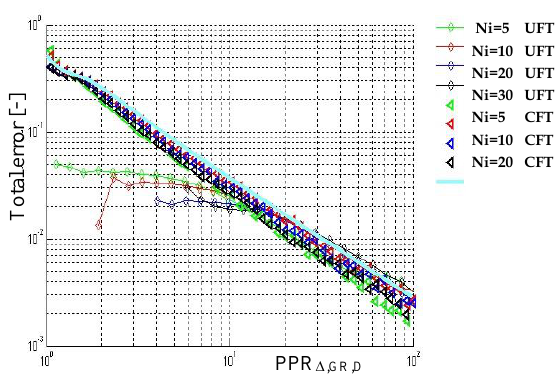
Fig. 7. Influence of seeding density and interrogation area size for PPR∆.